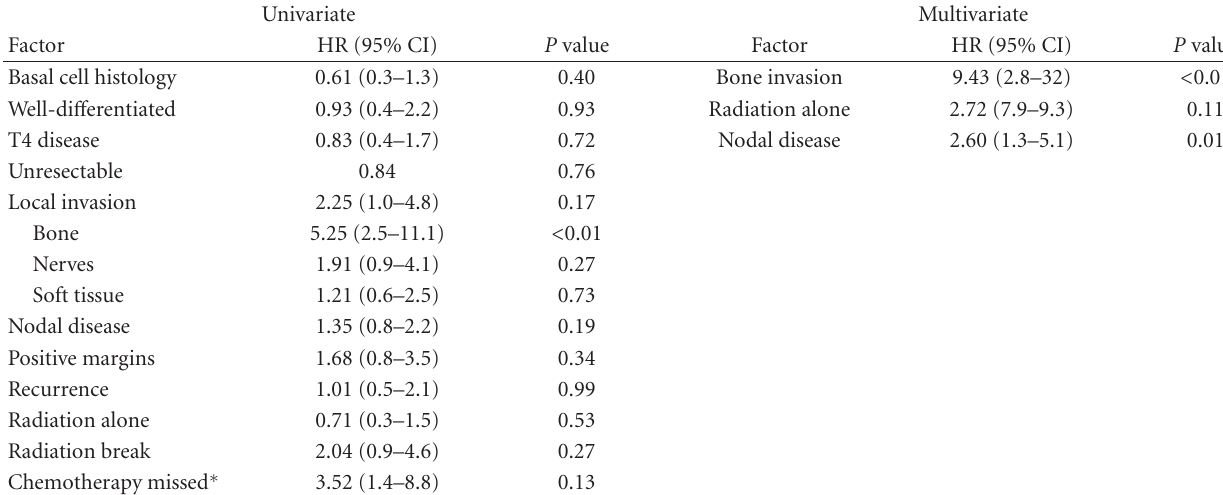
Table 3: Univariate and multivariate hazard ratios of relapse free survival.